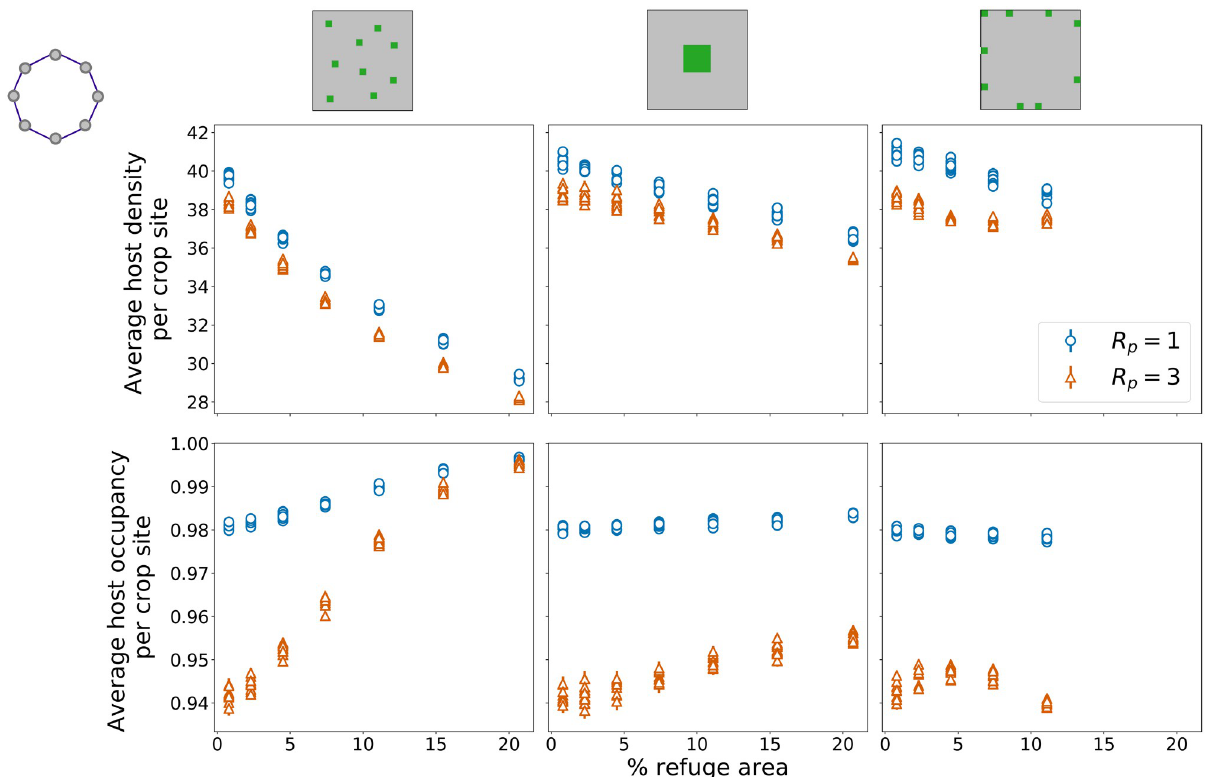
Fig 2. Host variables—Ring network. Average host density per crop site (first row) and average host occupancy per crop site (second row) as functions of the percentage of refuge areas on the lattice, for random, block, and border distributions of refuge areas (first, second, and third columns, respectively). Ten points are shown for each percentage of refuge areas, one for each node on the external network. Each point corresponds to the average density or occupancy for that node over 50 simulations, with error bars showing one standard error of the mean. Results are shown for two values of parasitoid dispersal radius R = 1 (blue circles) and R = 3 (orange triangles). External network (regional connectivity) has ring topology. P P